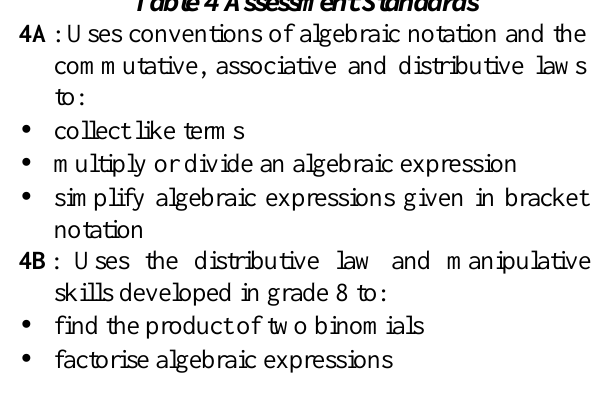
Table 4 Assessment Standards